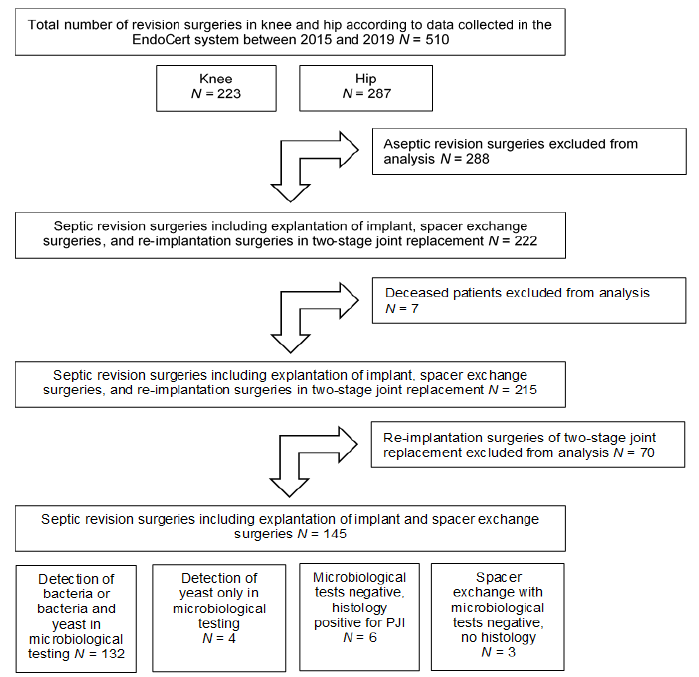
Figure 1. Scheme displaying the screening as well as the inclusion and exclusion of surgical procedures for the analysis regarding the incidence of fungal infections in PJI.